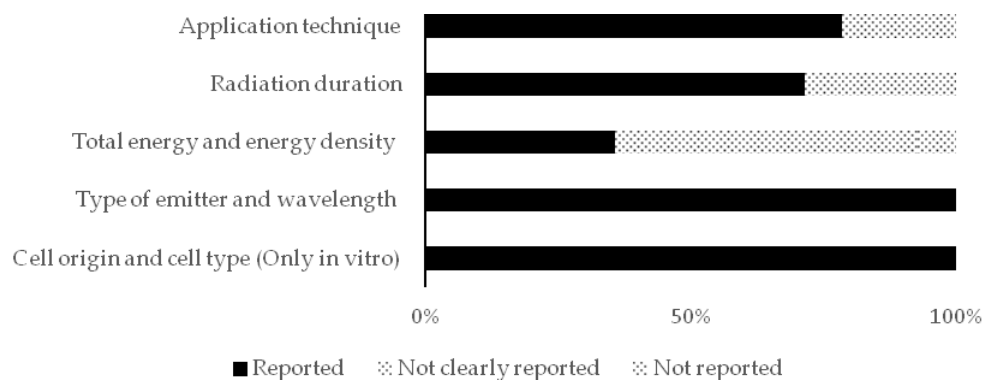
Figure 3. Risk of bias assessment scores in the in vitro studies ( n = 9) presented in percentage of articles (% of total).